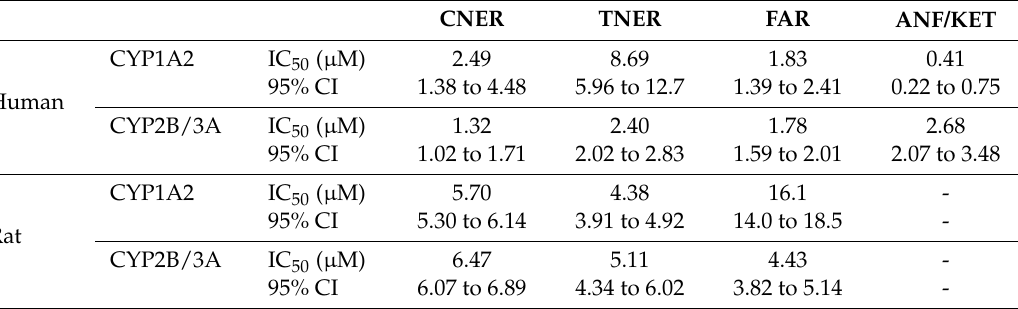
Table 2. Inhibition concentration (IC 50 ) of sesquiterpenes CNER, TNER, FAR, and of specific inhibitors ANF (CYP1A2) and KET (CYP2B/3A) to CYP1A2 (EROD activity) and CYP2B/3A (BROD activity) in human and rat liver microsomes.